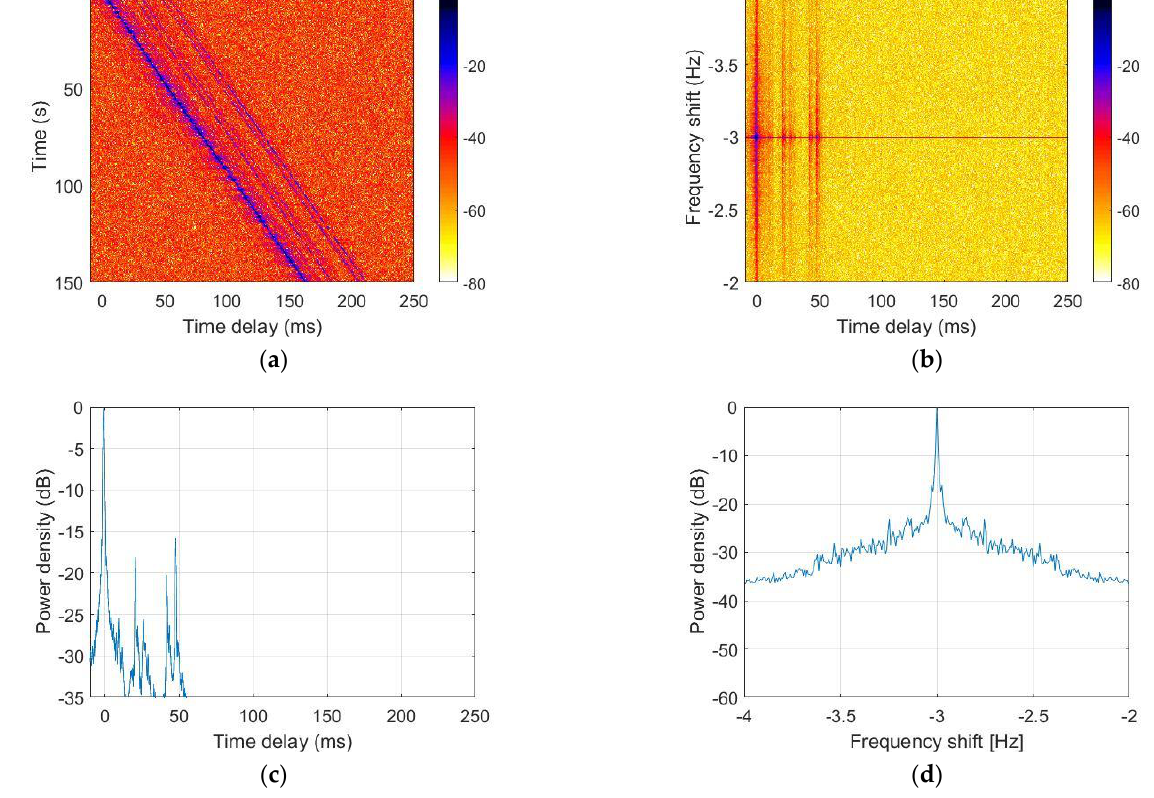
Figure 13. Underwater channel characteristics in the sea trial: ( a ) channel impulse response, ( b ) scattering function, ( c ) power delay profile, and ( d ) Doppler power spectrum.